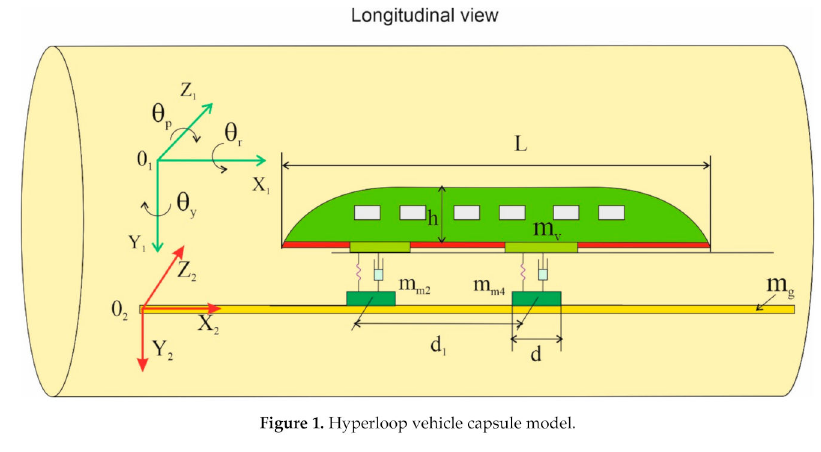
Figure 1. Hyperloop vehicle capsule